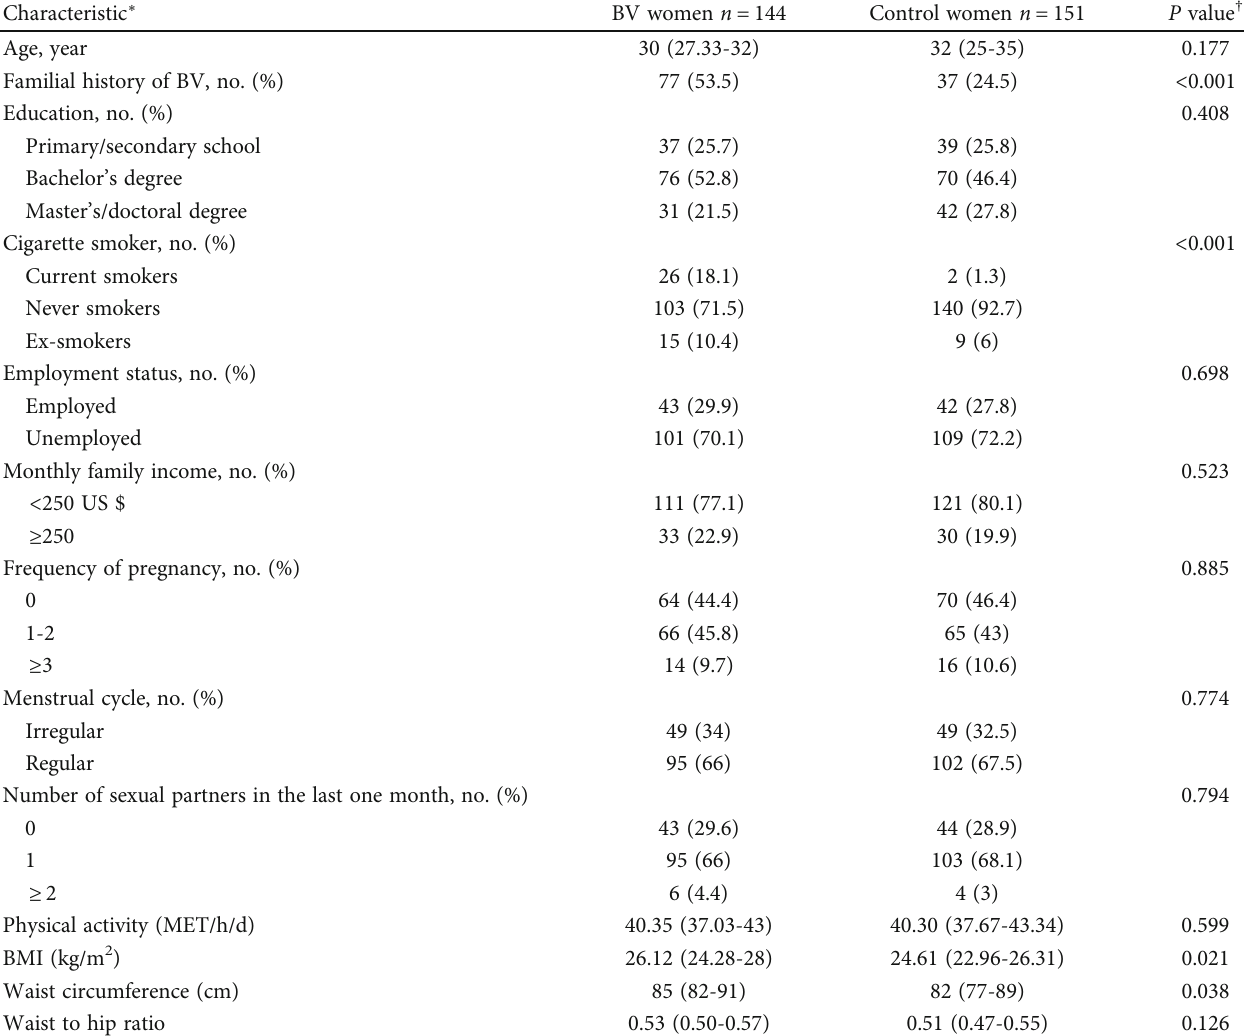
Table 1: General characteristics of participants with bacterial vaginosis and